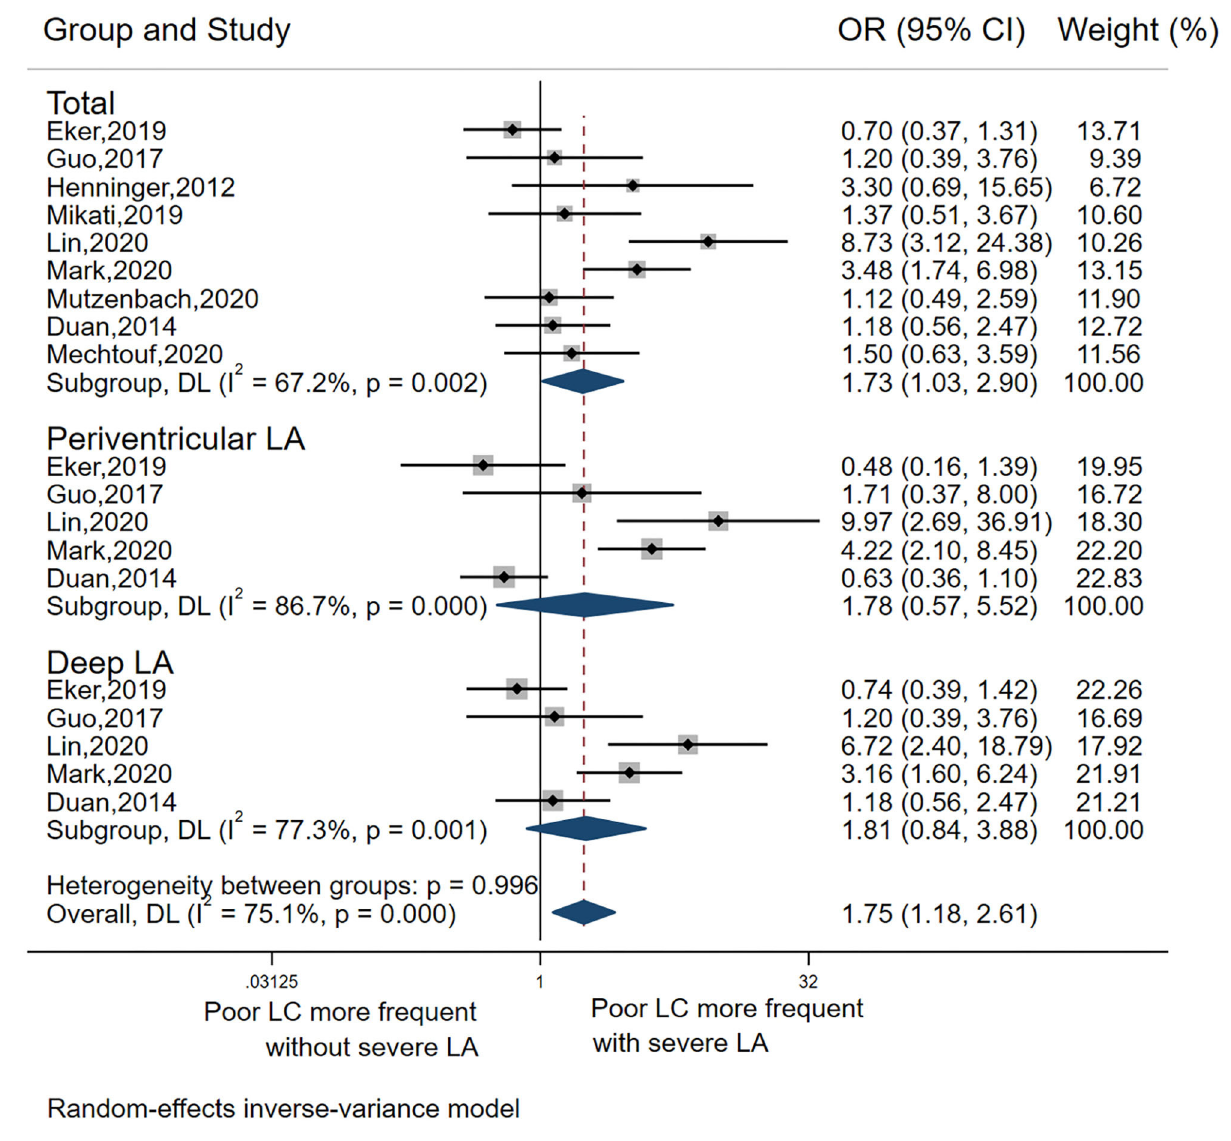
FIGURE 3 | Forest plot for the association between LA distribution and poor